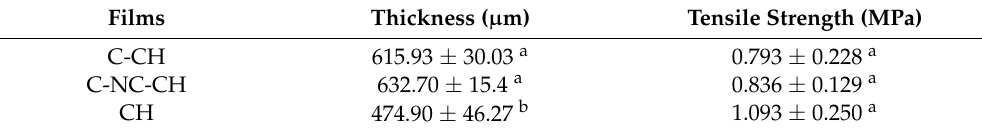
Table 2. Films’ mechanical properties.